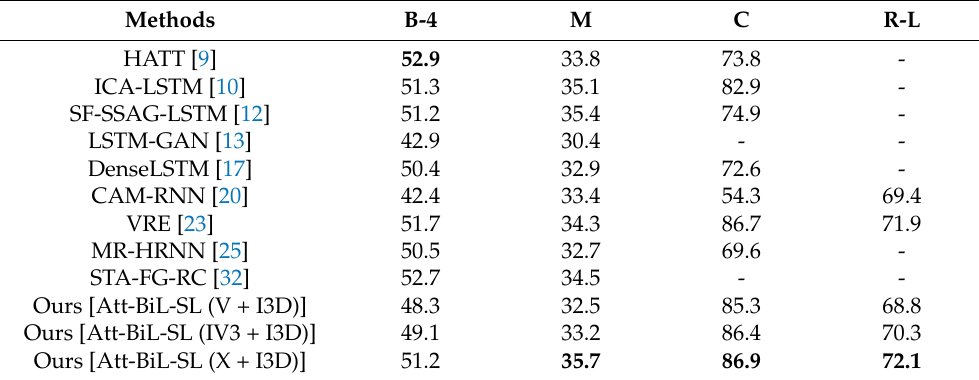
Table 2. Evaluation results of our method and previous methods for the video description generation on MSVD dataset. Here, “-” indicates the metric is not considered. All the numerical terms are in percentile format. Texts with bold marks are the best scores.